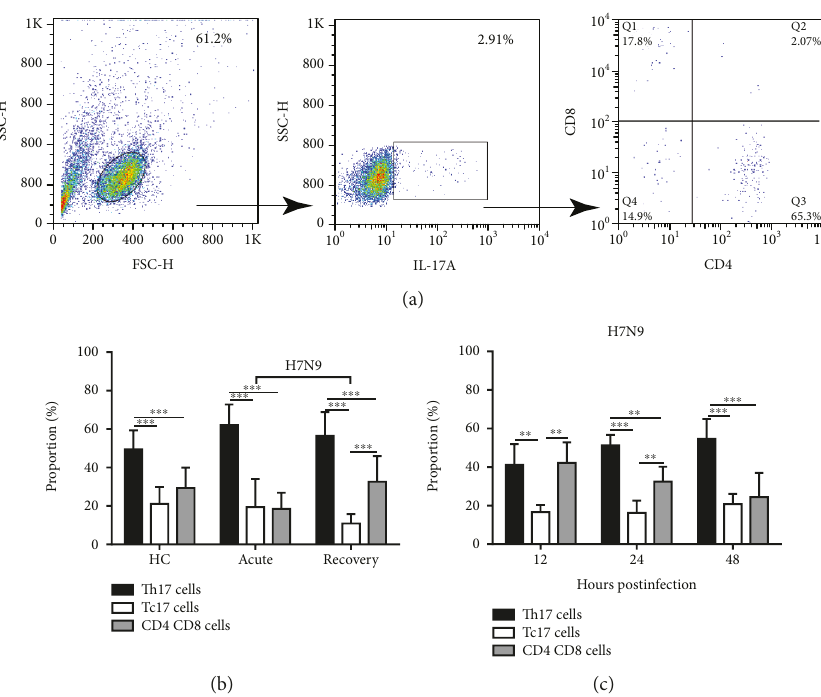
Figure 5: Th17 cells were the principal sources of IL-17A among PBMCs obtained from H7N9 patients and infected with the H7N9 virus in vitro . (a) Isolated PBMCs were initially gated for lymphocytes and IL-17A + cells, and the proportions of CD4 + CD8 - , CD4 - CD8 + , and CD4 - CD8 - cells were then analyzed. (b) The proportions of IL-17A + CD4 + CD8 - cells (Th17), IL-17A + CD4 - CD8 + cells (Tc17), and IL- 17A + CD4 - CD8 - cells from HC and H7N9 patients in the acute and recovery phases, respectively ( n = 20 ). (c) The proportions of IL- 17A + CD4 + CD8 - cells (Th17), IL-17A + CD4 - CD8 + cells (Tc17), and IL-17A + CD4 - CD8 - cells from healthy volunteers infected with the H7N9 virus in vitro at the indicated time points. ∗∗ P < 0 01 and ∗∗∗ P < 0 001